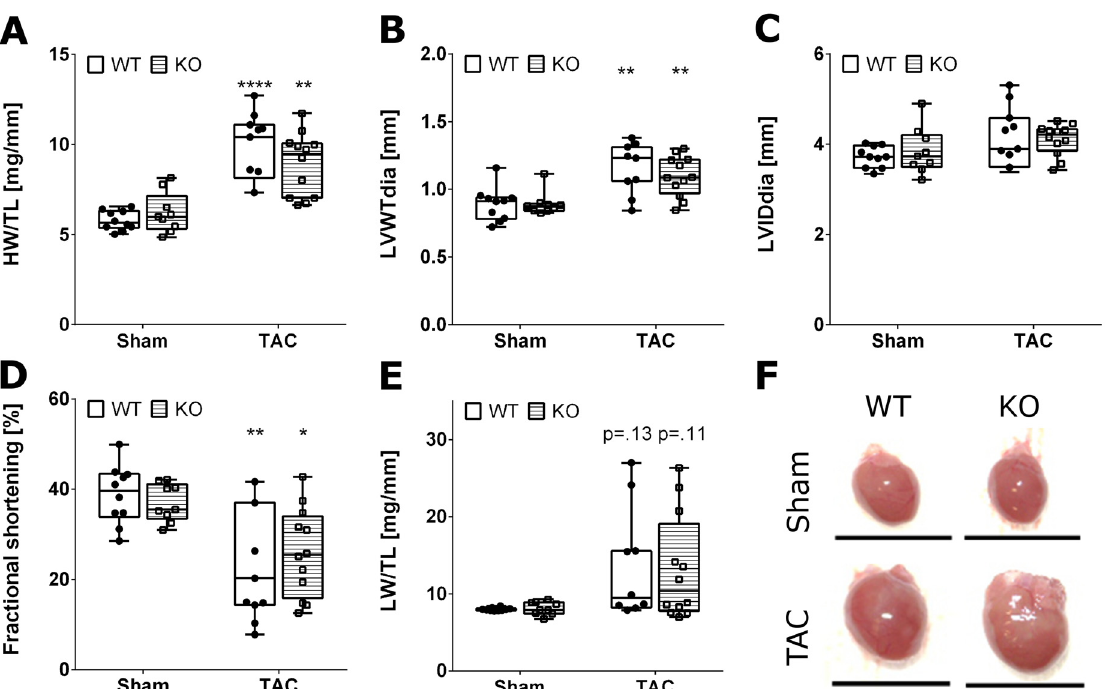
Fig 1. Gross morphological and functional analysis of Malat-1 WT and KO hearts after TAC. Increased heart weight/tibia length (A) and diastolic LV wall thickness (B) confirm concentric hypertrophy in both Malat-1 WT and KO mice without effects on diastolic LV inner diameter (C). Decreased fractional shortening (D) and lung congestion with increased lung weight/tibia length in some animals (E) indicate heart failure independent of Malat-1 deficiency. (F) Representative photographs of mouse hearts, Scale bar: 1 cm; * p < 0.05, ** p < 0.01, **** p < 0.0001 TAC versus